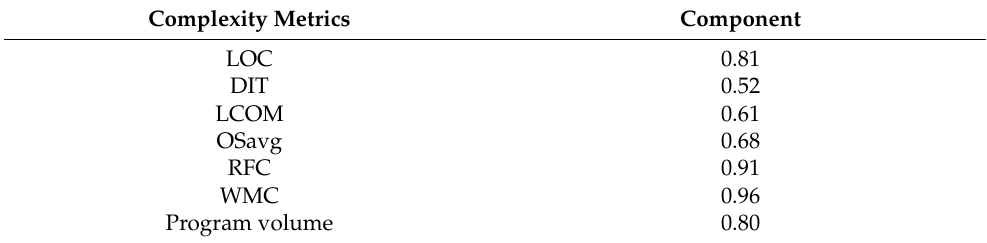
Table 2. Complexity component matrix for PCA dimension reduction